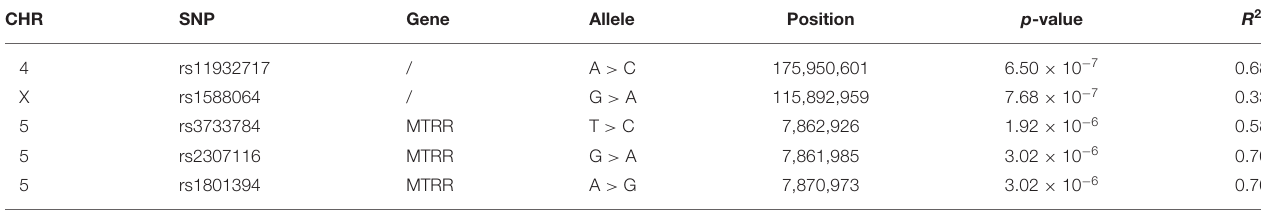
TABLE 2 | SNPs displaying significant association with the susceptibility to agitation by GWAS ( n = 30).